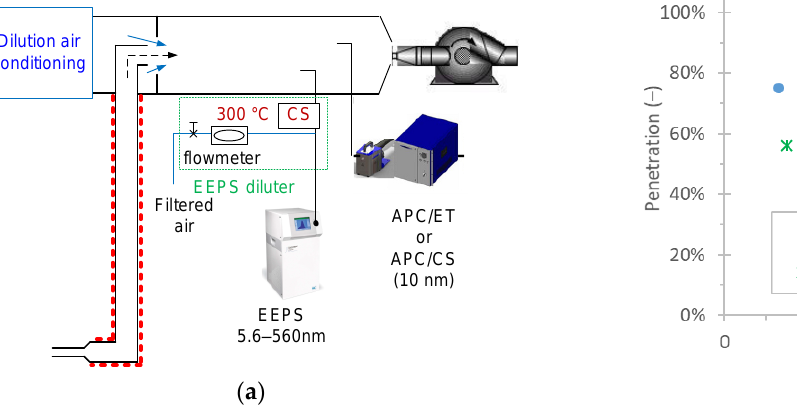
Figure 3. Vehicle testing: ( a ) experimental setup; ( b ) instrument penetrations. APC = AVL particle counter; CS = catalytic stripper; CVS = constant volume sampling; D = electrical mobility diameter; EEPS = engine exhaust particle sizer; ET = evaporation tube.